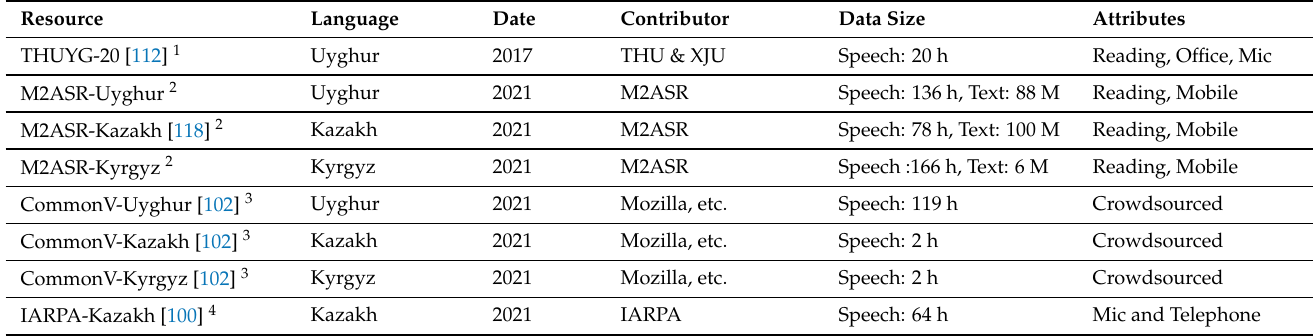
Table 3. Active resources for Uyghur, Kazakh, and